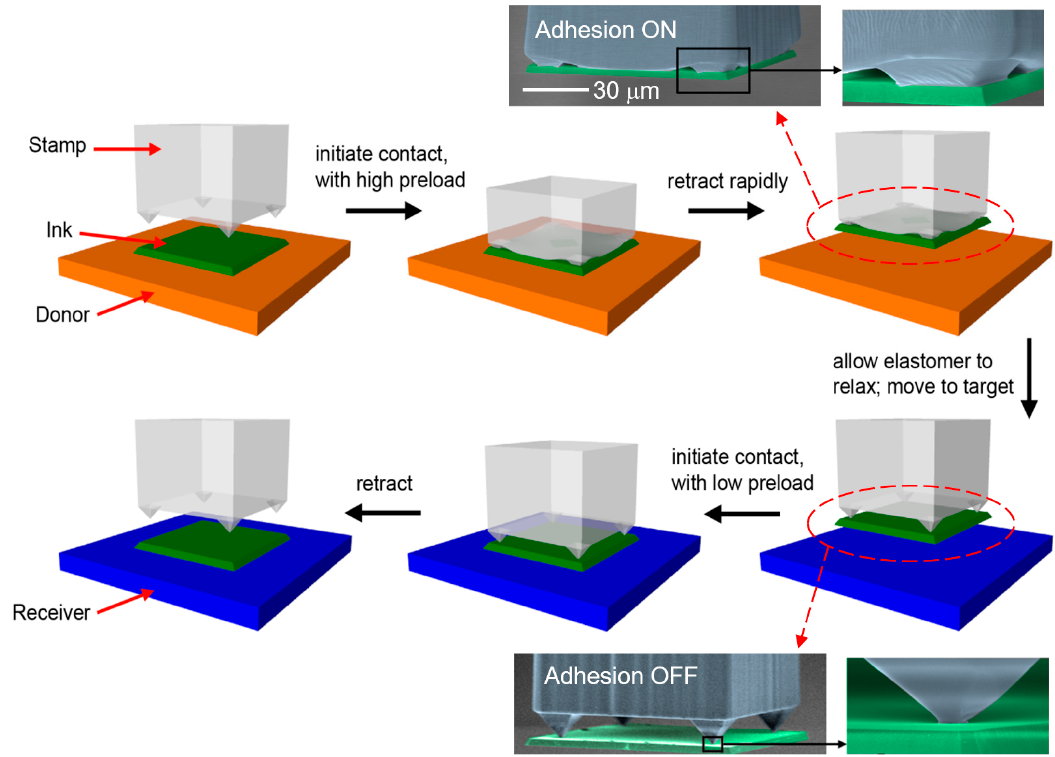
Figure 3. Implementation of an elastomer microtip stamp for transfer printing with corresponding colored SEM images. Reproduced with permission from [31,32].